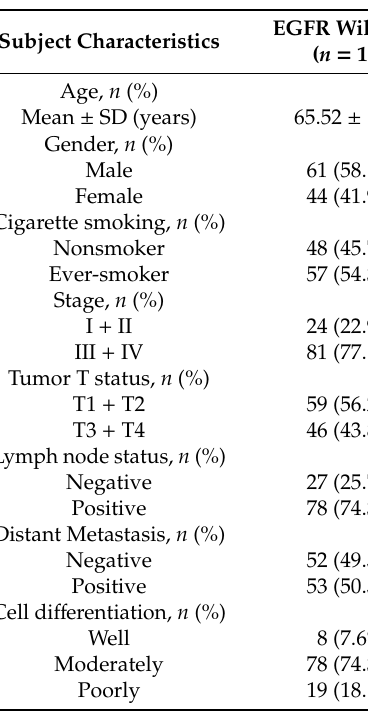
Table 1. Clinical characteristics in lung adenocarcinoma patients with epidermal growth factor receptor (EGFR), either wild type or mutation type.